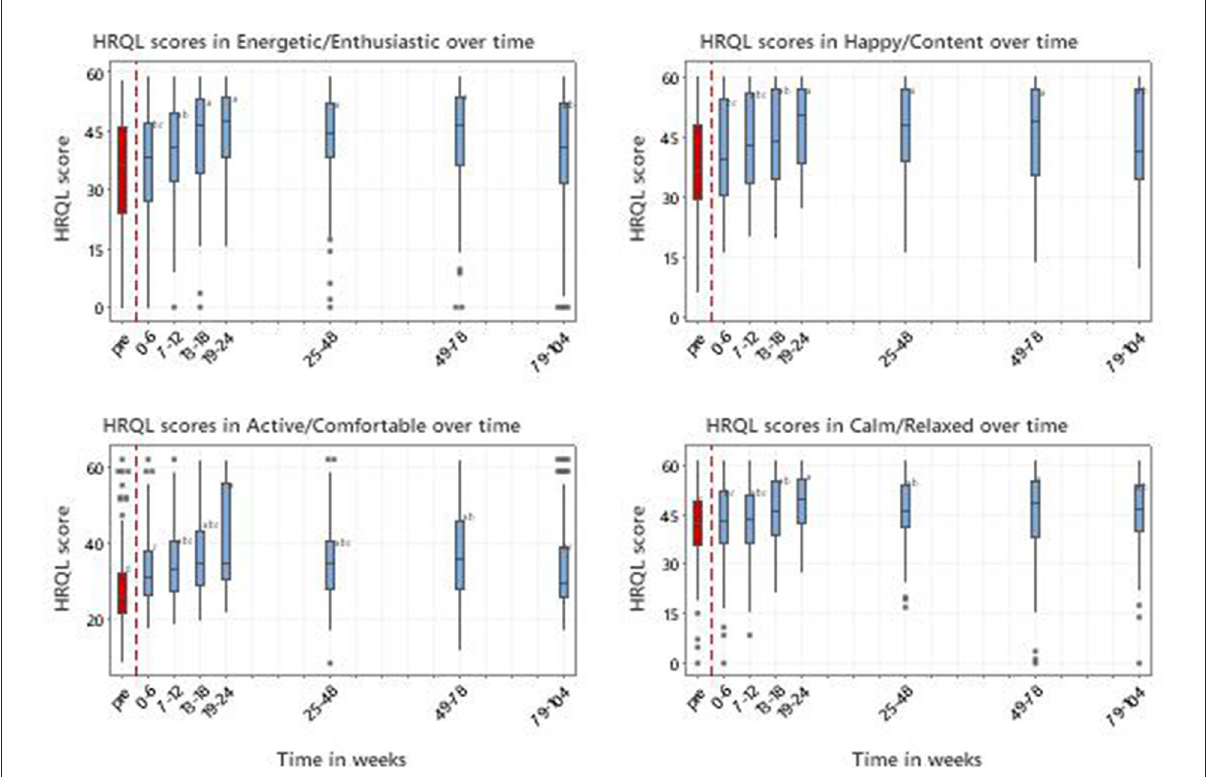
FIGURE9 Scores in 4 domains of QOL (Energetic/Enthusiastic; Happy/Content; Active/Comfortable; Calm/Relaxed) for 212 dogs with MSD treated with RM in time windows representing pretreatment (pre) and up to 104 weeks post initial treatment. 50 represents the score for the average healthy dog and 70% of healthy dogs will score above 44.8. Letters adjacent to each bar indicate which time windows are significantly different (i.e., those not sharing a common